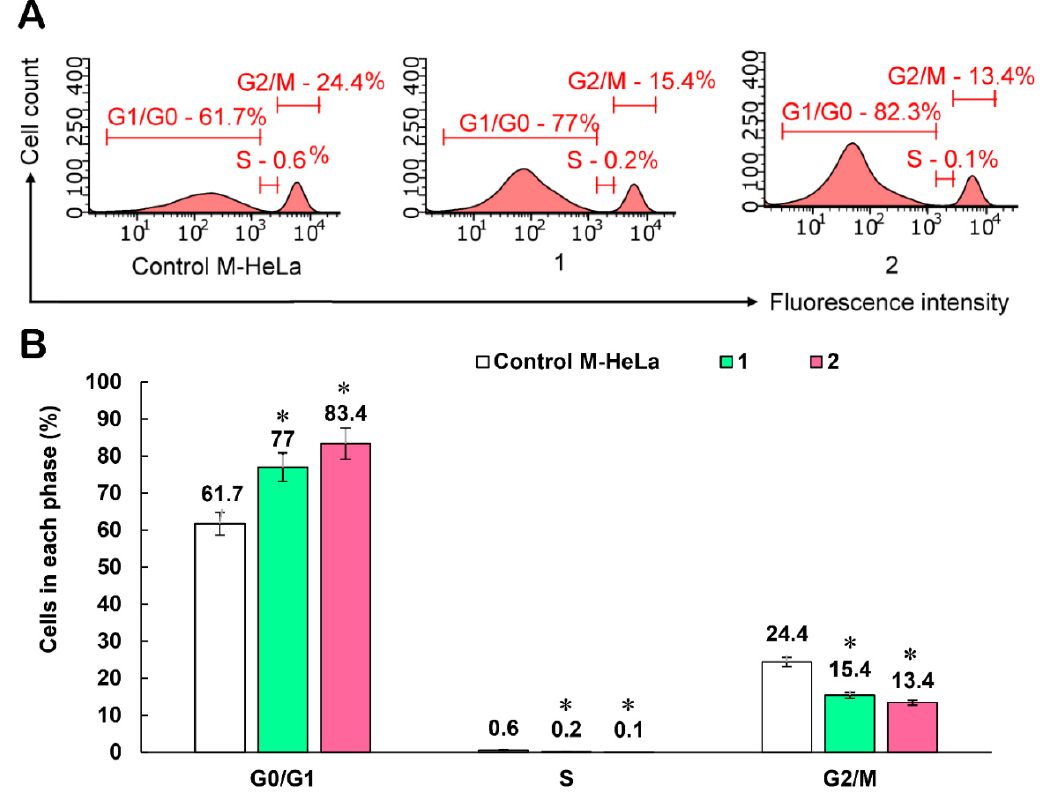
Figure 14. Effect of compound 7 on M-HeLa cell cycle arrest. 1—at concentration IC 50 /2 (6 µ M); 2—at concentration IC 50 (12 µ M); ( A ) cell distribution histograms. ( B ) Percentage of cells in the G0/G1, S, and G2/M phases (data are presented as mean ± SD of three independent experiments). * Values indicate p < 0.05.